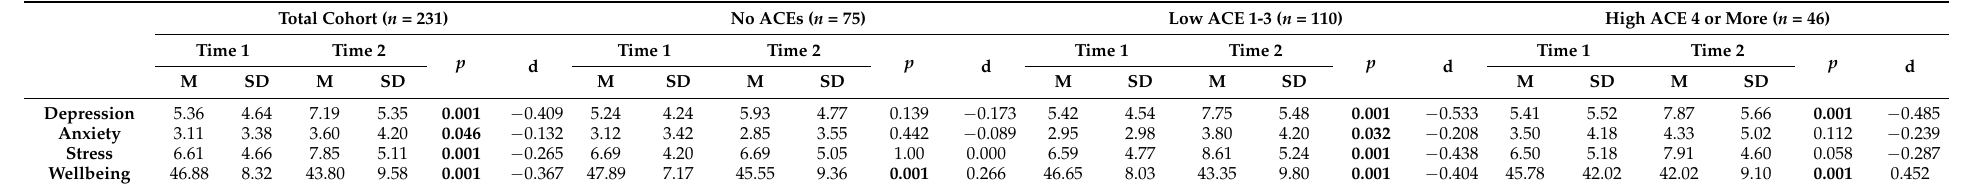
Table 1. Mean and Standard Deviations across psychological wellbeing variables over time, stratified by ACE